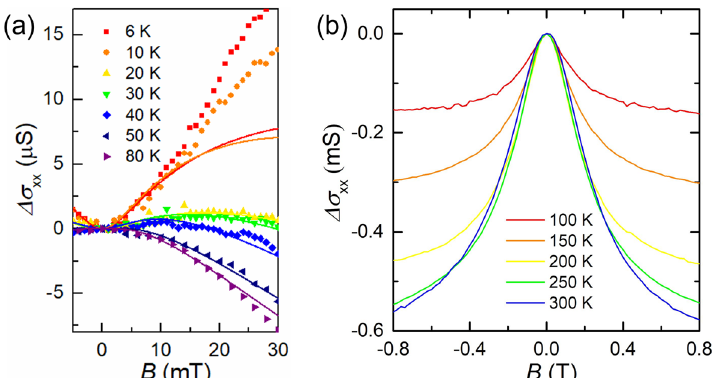
Figure 2. ( a ) Magnetoconductance of the device at the DP for the low temperature magnetic field regime. The symbols show the experimental data, while the solid lines represent the fitting results using Eq. (1). ( b ) Magnetoconductance for the relatively high temperature, magnetic field regime. The lines correspond to the experimental